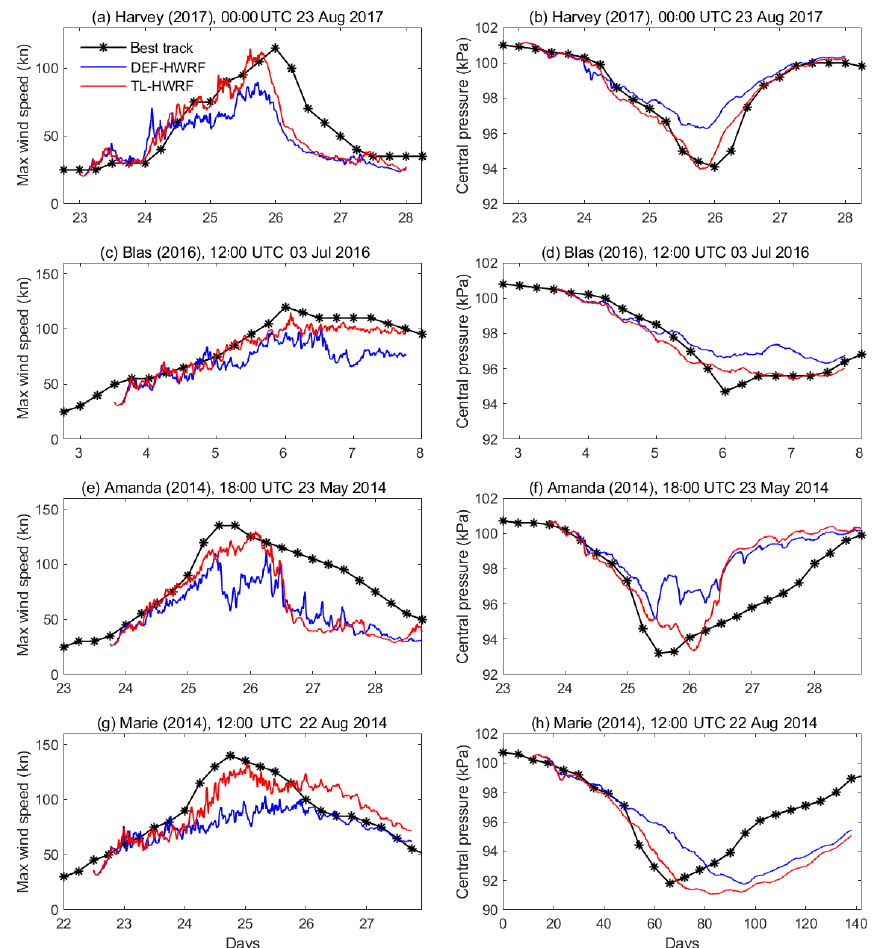
Figure 13. HWRF-simulated maximum wind speed and storm central pressure of four other major hurricanes, Harvey (2017), Blas (2016), Amanda (2014), and Marie (2014), compared with the best-track data (black curves). Blue curves: DEF-HWRF. Red curves: